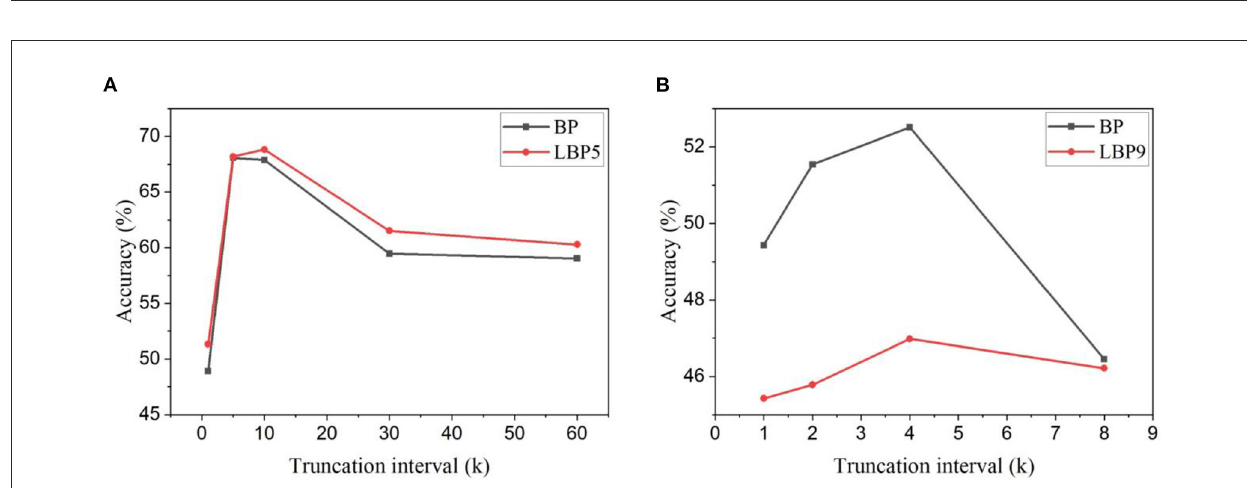
decreases when the interval becomes small. This phenomenon k can cause the network not to converge, thus resulting in